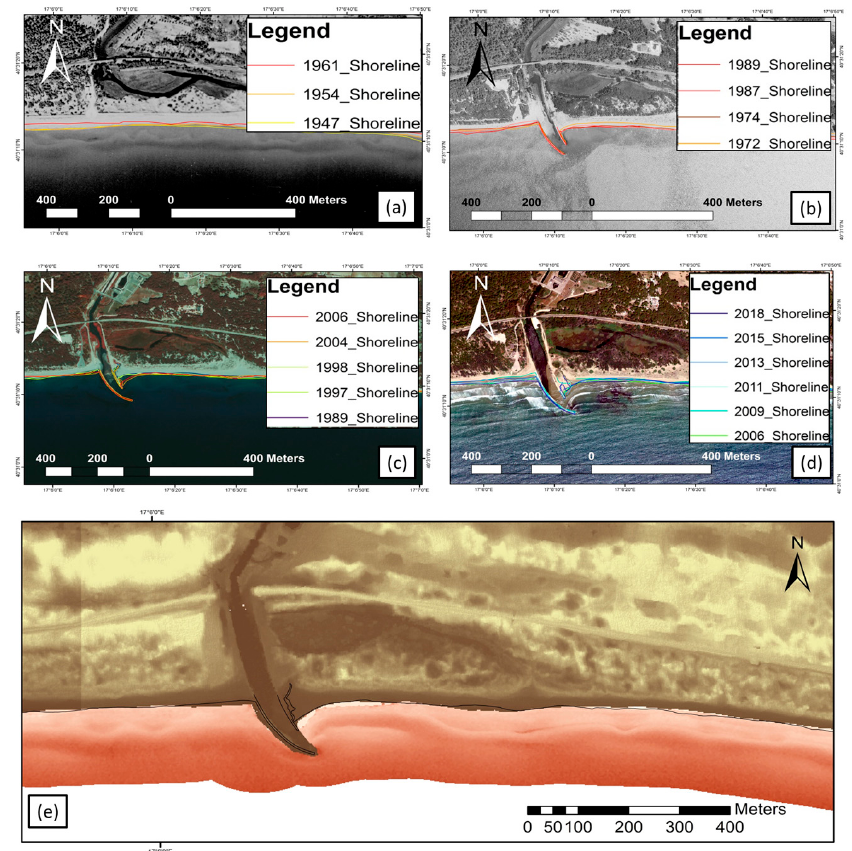
Figure 12. Shoreline changes close to the Patemisco River mouth: ( a ) 1954 basemap with 1947–1961 super-imposed shorelines; ( b ) 1974 basemap with 1972–1989 super-imposed shorelines; ( c ) 1989 basemap with 1989–2006 super-imposed shorelines; ( d ) 2013 basemap with 2006–2018 super-imposed shorelines; and ( e ) Laser Imaging Detection and Ranging of 2009 nearshore topography and morpho-bathymetry.